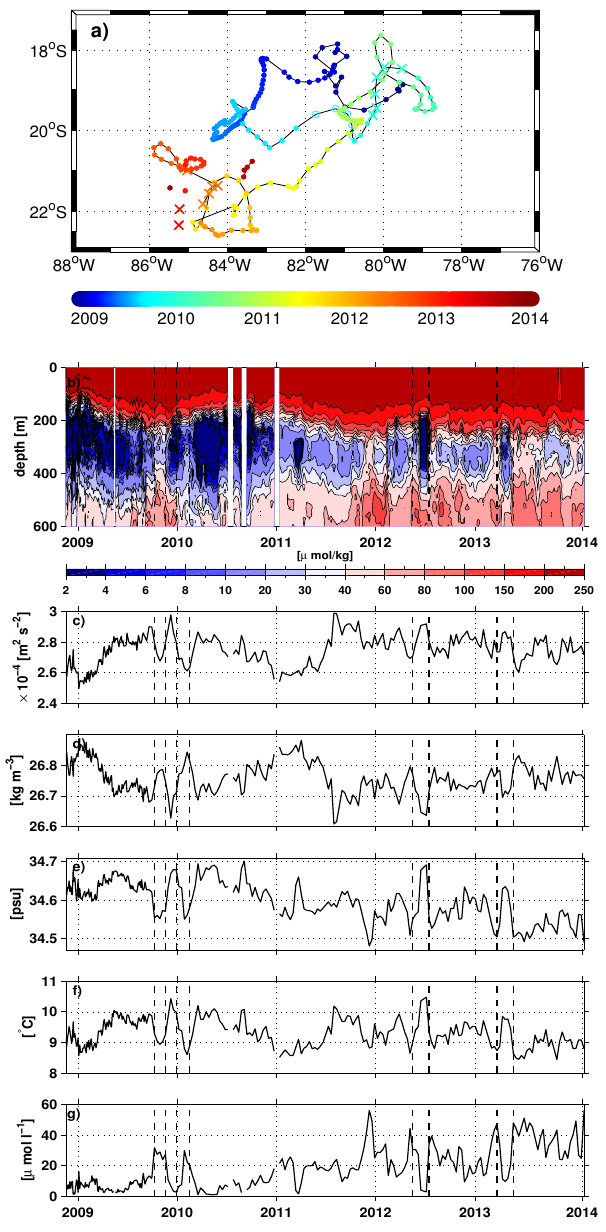
Figure 7. Measurements of float 3900729 in the tropical eastern South Pacific between 18 November 2008 and 6 February 2014 with (a) float path (color coded), (b) oxygen distribution versus time in the upper 600m, (c) geopotential anomaly (450 to 250m), (d) po- tential density anomaly in 350m depth, (e) salinity in 350m, (f) po- tential temperature in 350m, and (g) oxygen in 350m. The resi- dence time of the float in two cyclonic eddies (10 October to 19 November 2009, 29 December 2009 to 17 February 2010) and two anticyclonic mode water eddies (17 May to 16 July 2012, 23 March to 22 May 2013) is marked by Xs (a) and dashed black lines (b–g) . In 2013 some profiles were recorded without the geographical loca- tion and only locations recorded are shown by dots or crosses not connected by a